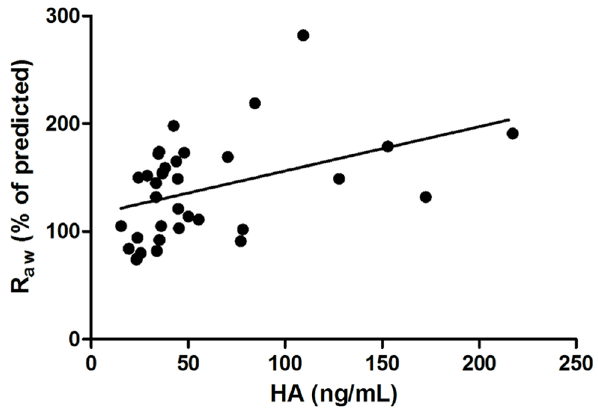
Figure 5. ROC analysis of HA values in asthmatic non-pregnant patients with controlled and uncontrolled disease according to ACT total score. HA – hyaluronic acid; ACT – asthma control test.